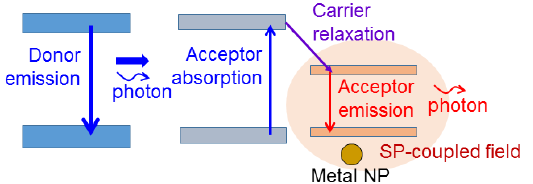
Figure 5. Schematic illustration of an SP-coupled down-conversion process when the SP resonance spectrum covers only the emission wavelength of the acceptor.